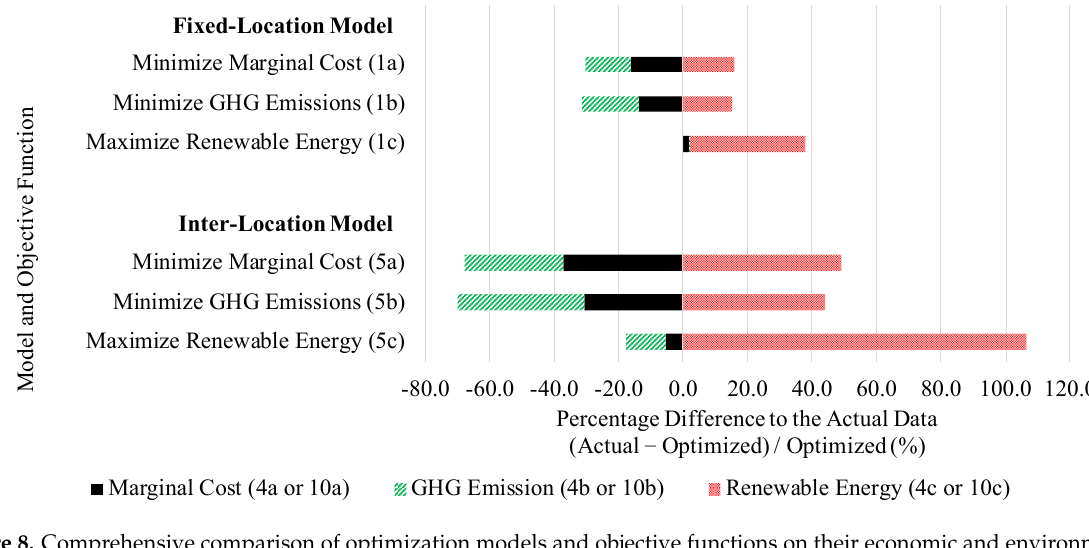
Figure 8. Comprehensive comparison of optimization models and objective functions on their economic and environmental performance (percentage difference explained via Equation